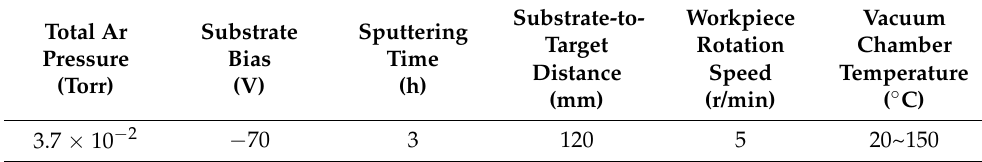
Table 3. The fixed parameters for the magnetron sputtering